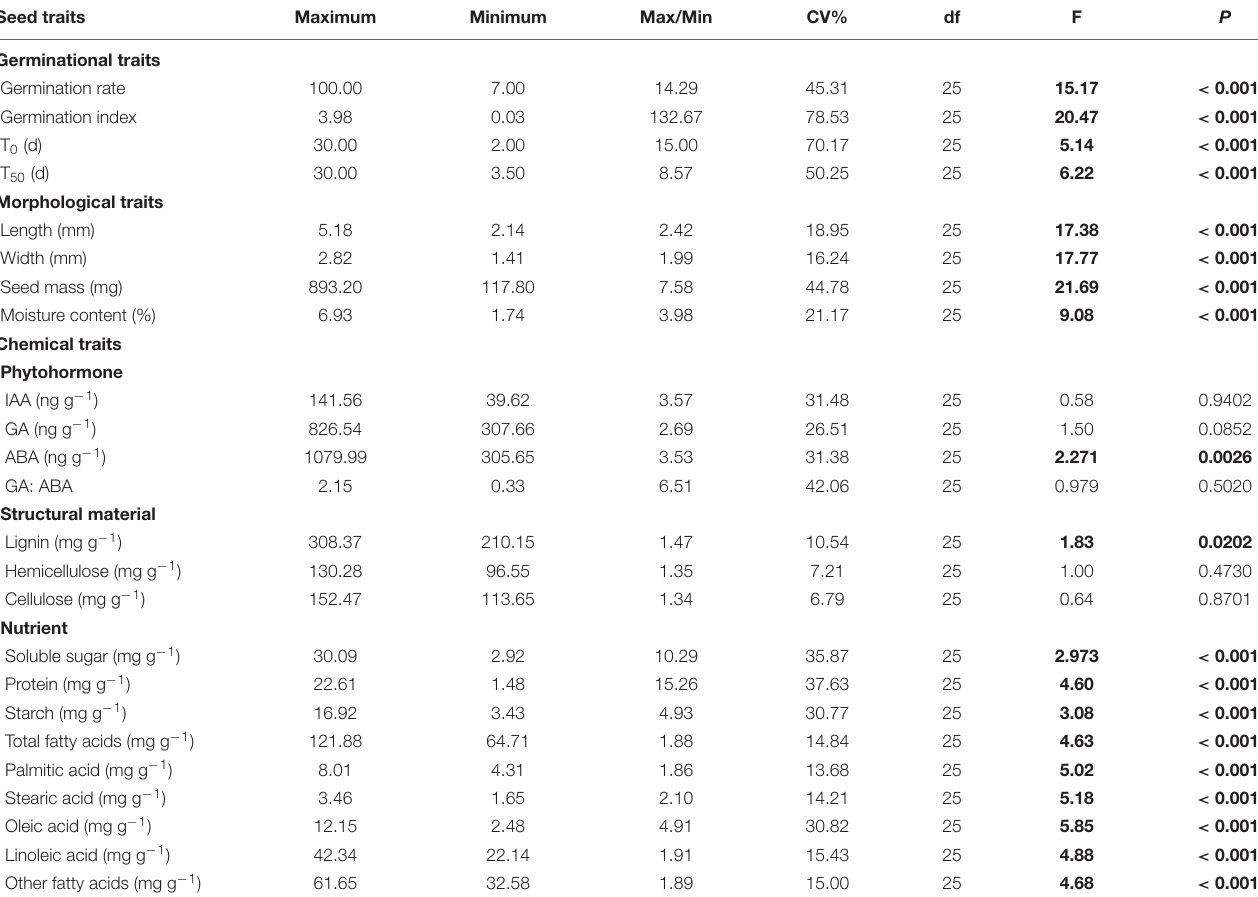
TABLE 2 | Seed trait variation of Ambrosia artemisiifolia from 26 populations in China. Seed traits Maximum Minimum Max/Min CV%